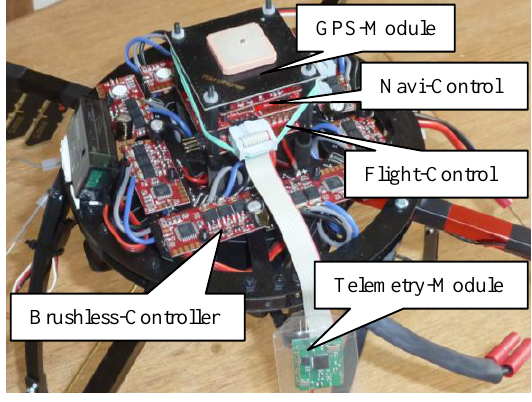
Figure 2. Electronic components for autonomous flight